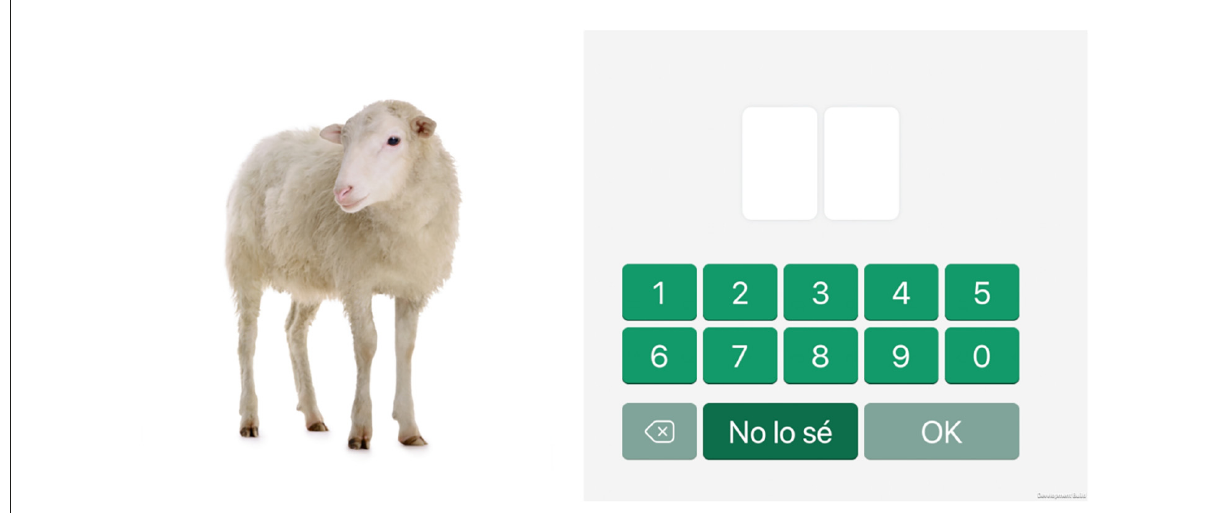
FIGURE3 Screenshot of the free recall mode of the free and cued image and number associations